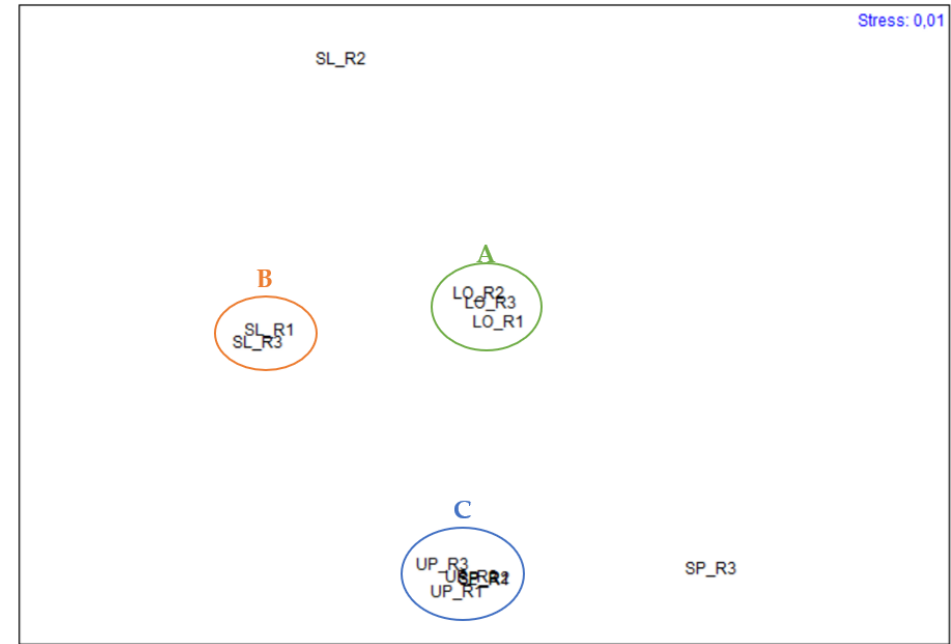
Figure 2. n-MDS of the four species studied, regarding the fatty acid profile: Laminaria ochroleuca (LO_R1, LO_R2, LO_R3), Saccharina latissima (SL_R1, SL_R2, SL_R3), Sacchorriza polychides (SP_R1, SP_R2, SP_R3), and Undaria pinnatifida (UP_R1, UP_R2, UP_R3). Group A is composed of LO_R1, LO_R2, and LO_R3 samples; group B is composed of SL_R1 and SL_R3 samples; Group C is composed of UP_R1, UP_R2, UP_R3, SP_R1, and SP_R2 samples. Table 5. SIMPER results regarding similarities (sim.) within the groups identified (A— Laminaria within groups are provided by the average similarity within each group (Av. Sim. within each group)–the higher the similarity (tending to 100), the higher the similarity within each group. The three FAs that contribute the most to the similarity in each group are shown, as well as the percentage of that contribution and the cumulative contribution of the three FAs for the total similarity of each group, in percentage. Replicates SL_R2 and SP_R3 were considered outliers of the analysis.